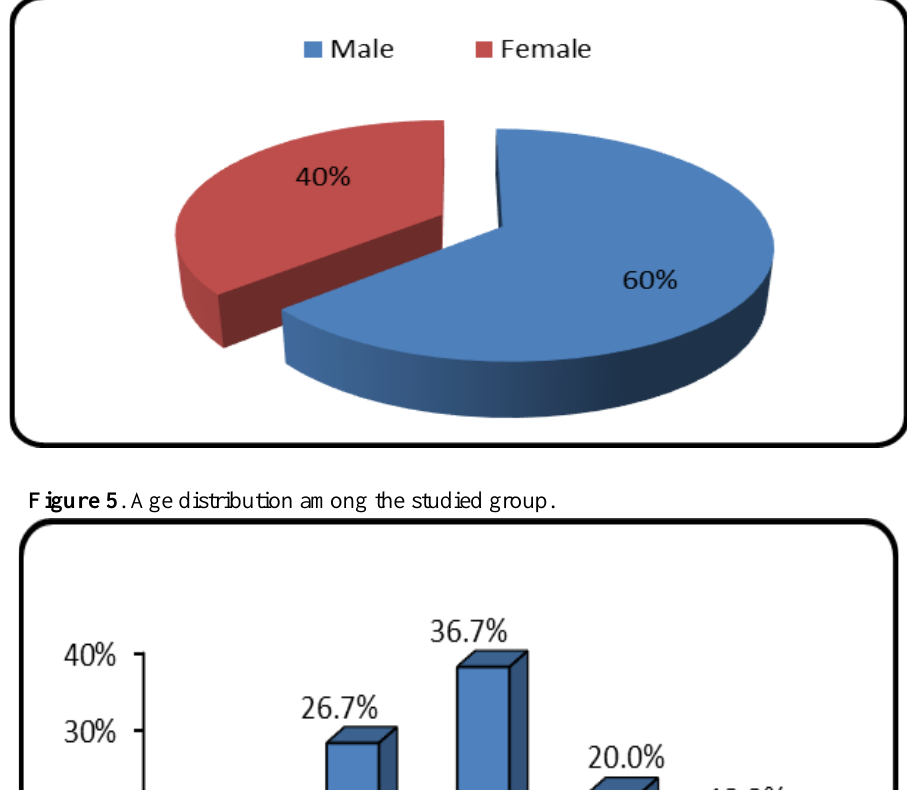
Figure 4. Sex distribution among the studied group.